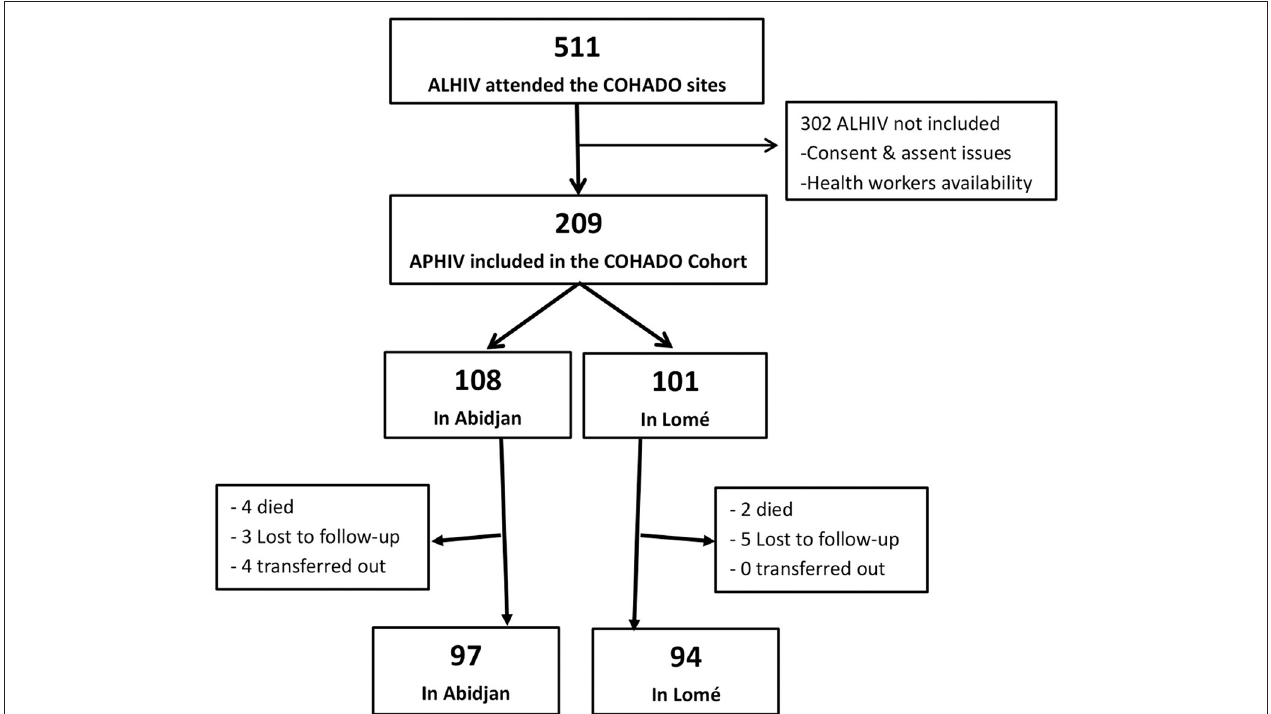
FIGURE 1 | Flow chart of the 209 APHIV participant in the COHADO Cohort, IeDEA-pWADA, 2015.